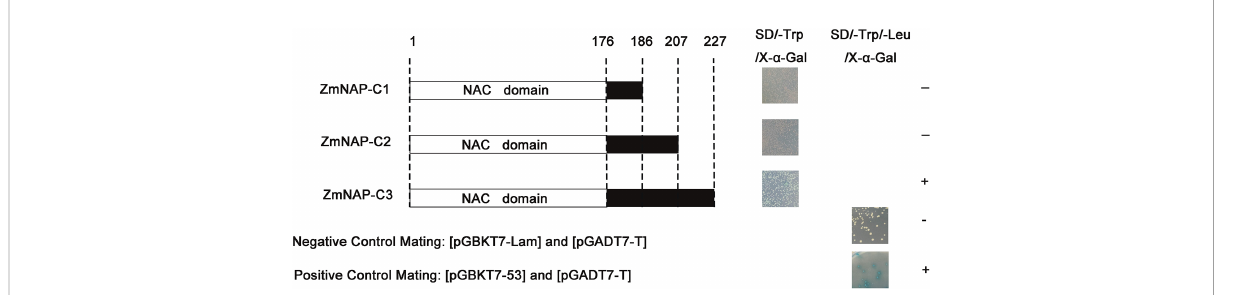
FIGURE 11 Screening and identi fi cation of ZmNAP interacting proteins in Y2HGlod yeast. Three truncations of ZmNAP were ligated into the pGBKT7 vector. Recombinant vectors were transformed into Y2HGold and selected on SD/-Trp/X- a -Gal and SD/-Trp/-Leu/X- a -Gal. The pGBKT7-Lam and pGADT7-T were used as the negative control. The pGBKT7-53 and pGADT7-T were used as the positive control. Experiments were independently repeated at least three times.